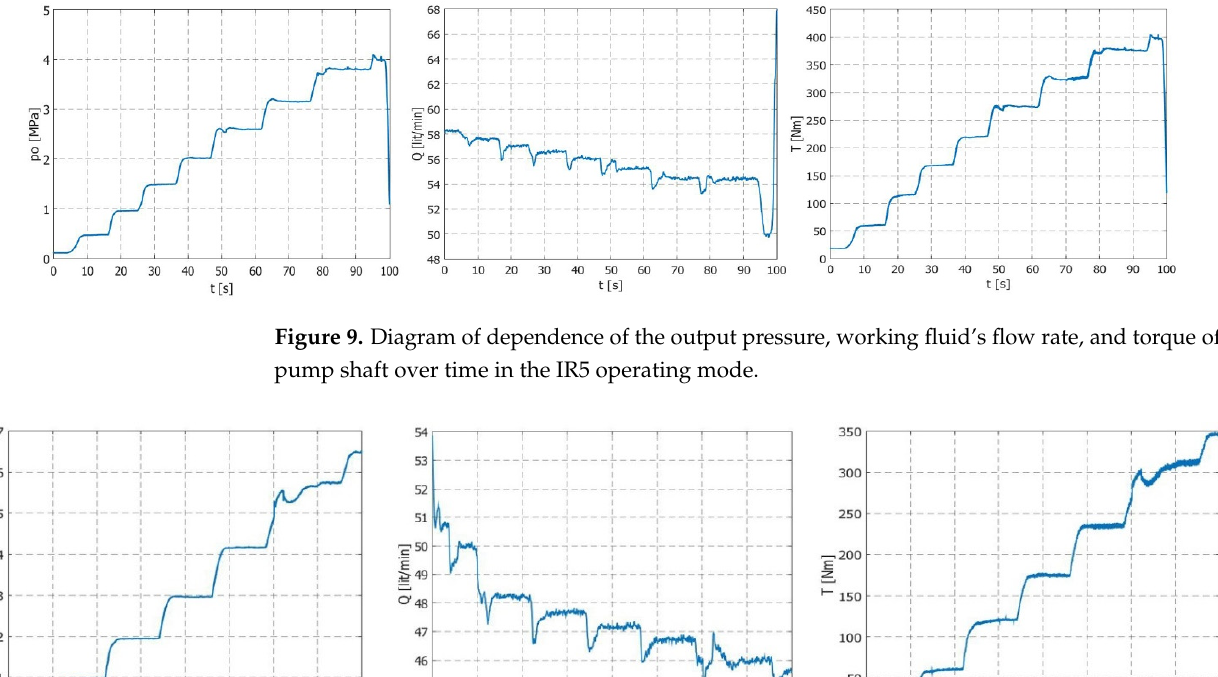
Figure 10. Diagram of dependence of the output pressure, working fluid’s flow rate, and torque of the pump shaft over time in the IR6 operating mode.